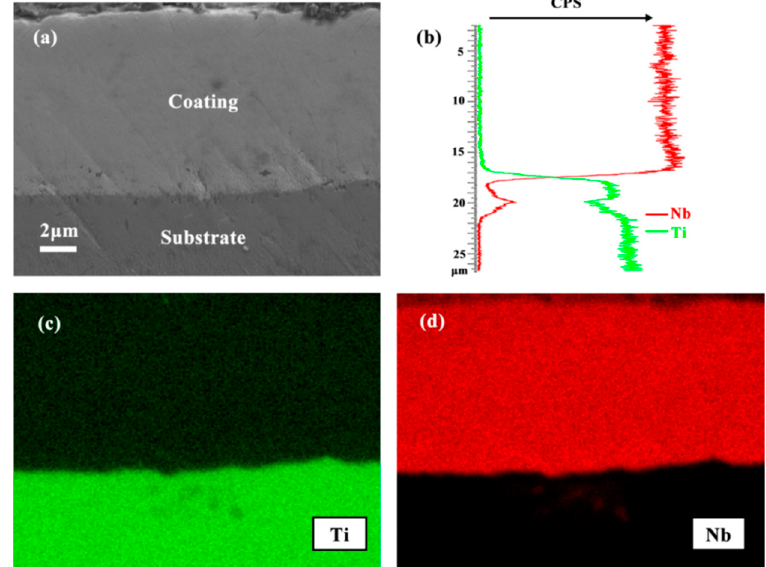
Figure 2. ( a ) SEM micrograph of the cross section of the Nb coating, ( b ) the energy-dispersive X-ray